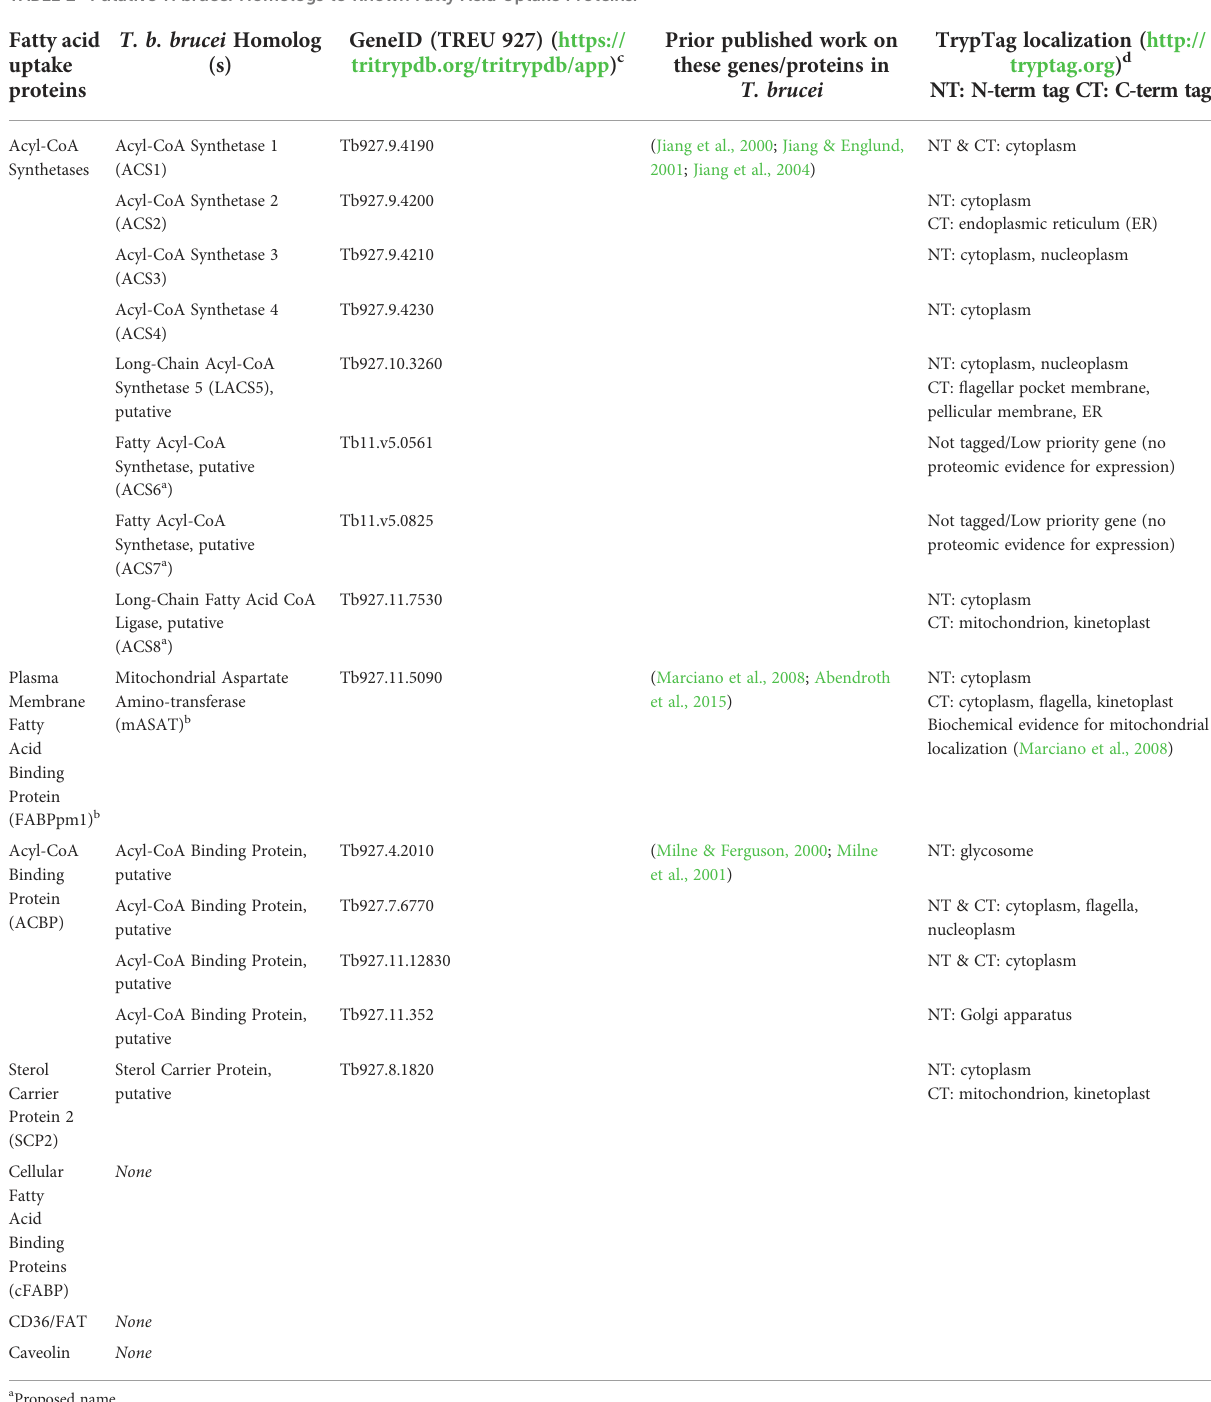
TABLE 2 Putative T. brucei Homologs to Known Fatty Acid Uptake